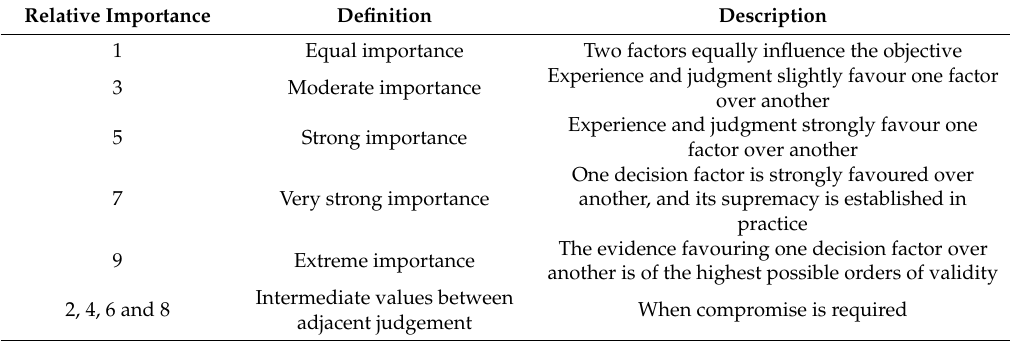
Table 3. Scale of relative importance (adapted from Saaty